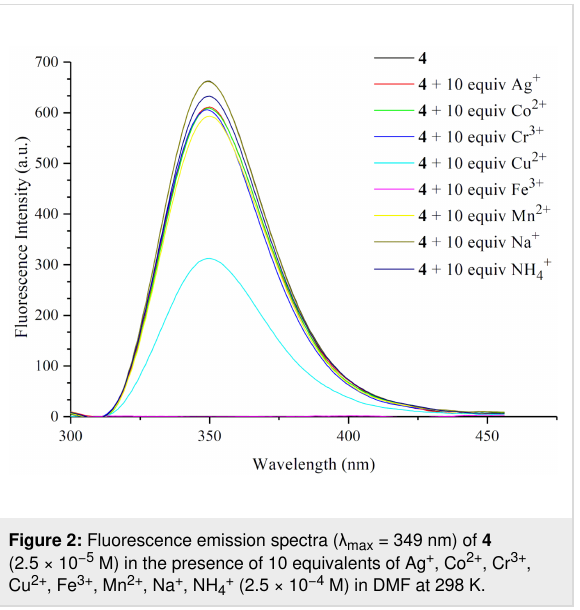
Figure 2: Fluorescence emission spectra ( λ max = 349 nm) of 4 (2.5 × 10 − 5 M) in the presence of 10 equivalents of Ag + , Co 2+ , Cr 3+ , Cu 2+ , Fe 3+ , Mn 2+ , Na + , NH 4 + (2.5 × 10 − 4 M) in DMF at 298 K.